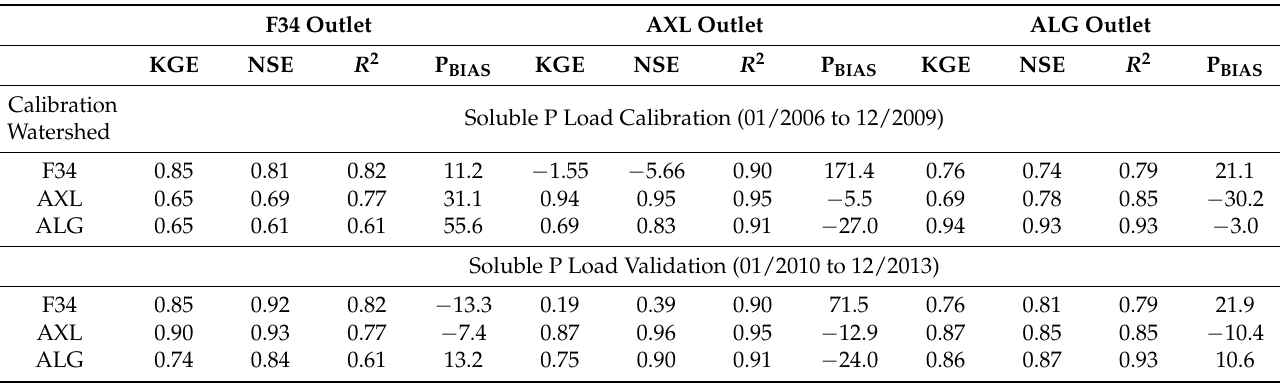
Table 11. Soluble P load calibration and validation statistical metrics for SWAT performance for CCW, F34, AXL, and